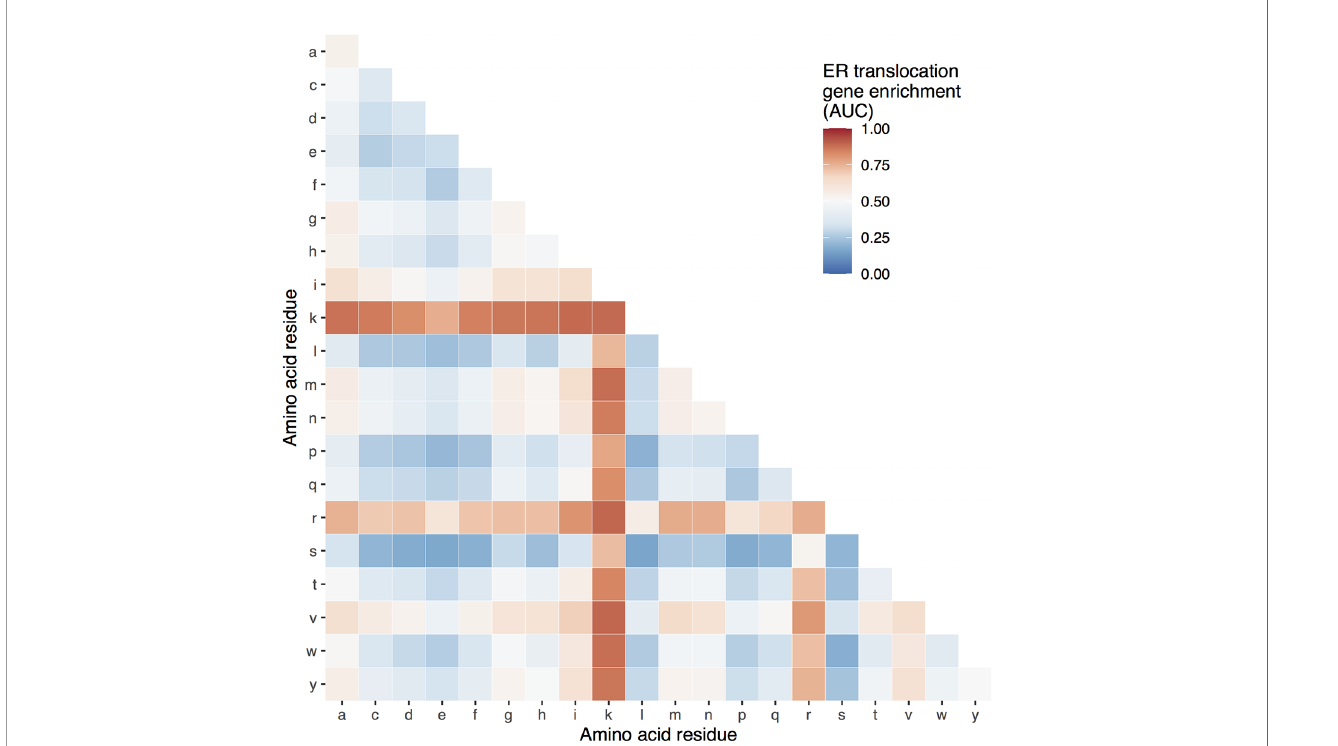
FIGURE 1 | Heatmap of ER translocation gene enrichment for proportions of different amino acid pairs. Relative to all other genes, proportions of speci fi c amino acid pairs for the ER translocation genes range from high (red) to low